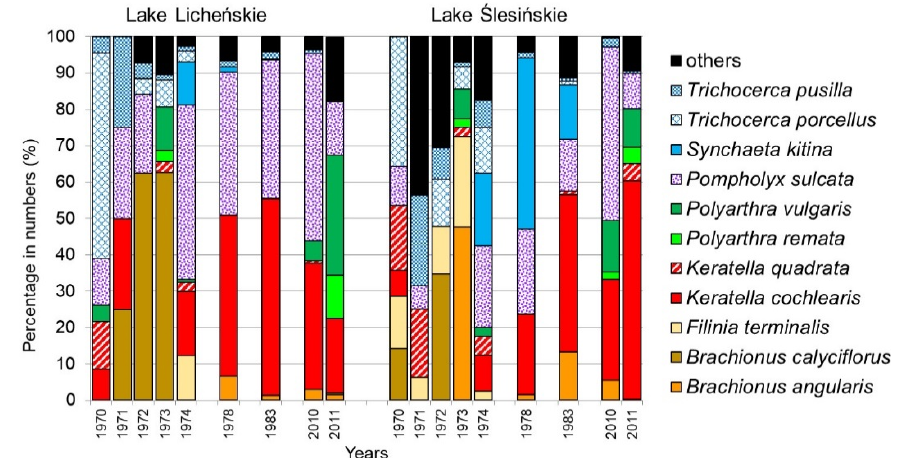
Figure 4. The percentage of dominant rotifer species in the total rotifer density in water column in Lake Liche ń skie and Lake Ś lesi ń skie in summer.